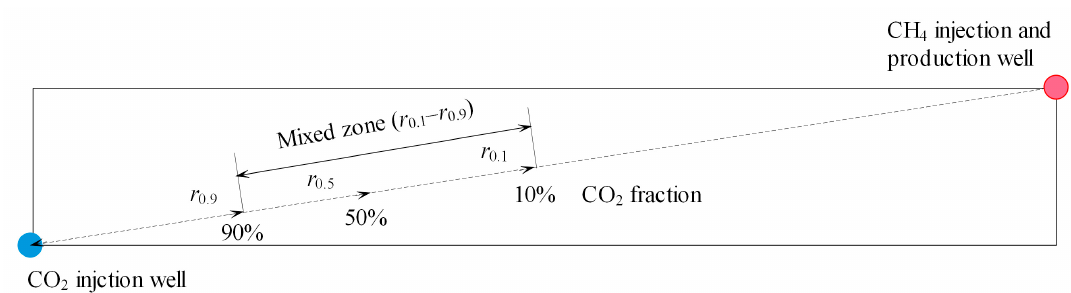
Figure 7. Schematic diagram of the mixed zone in the diagonal section of the reservoir.